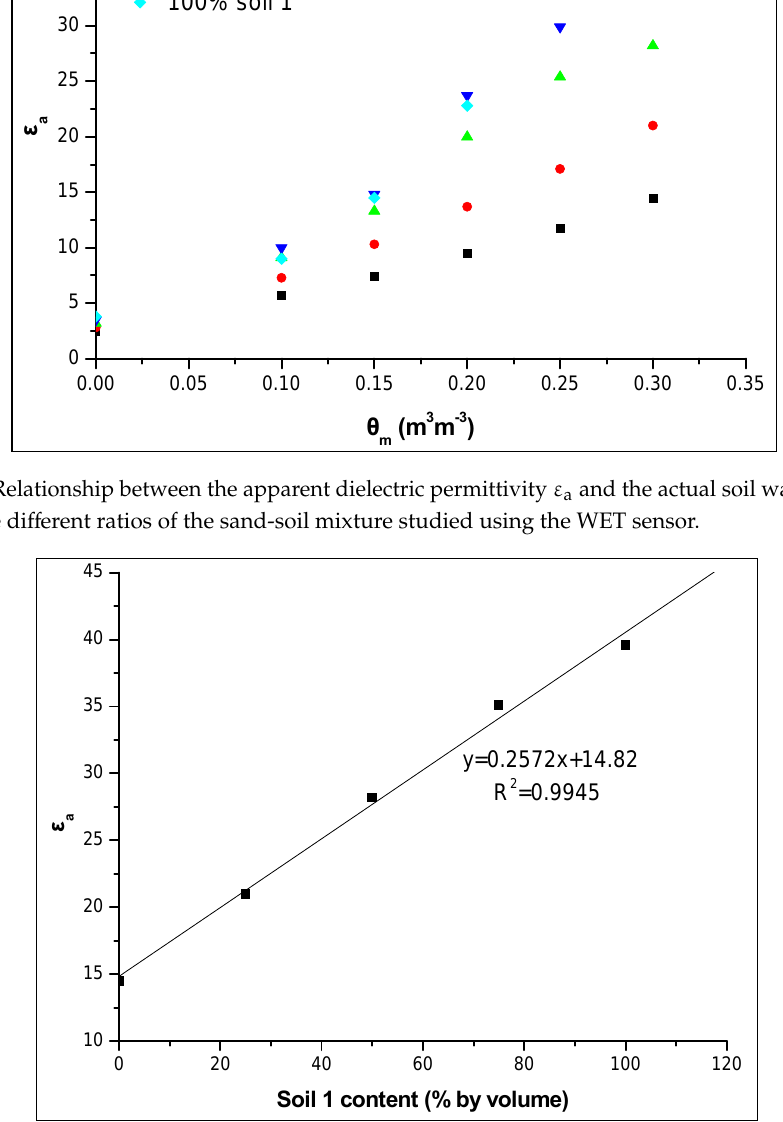
Figure 8. Relationship between the apparent dielectric permittivity ε a and the percentage of soil 1 in the soil mixture studied at the maximum actual soil water content using the WET sensor.